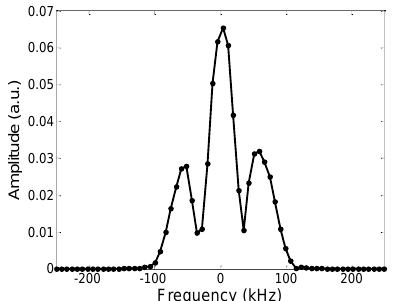
Figure 11. The result of identifying layered samples by the FFT method.